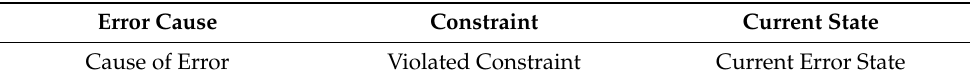
Table 4. Error table.